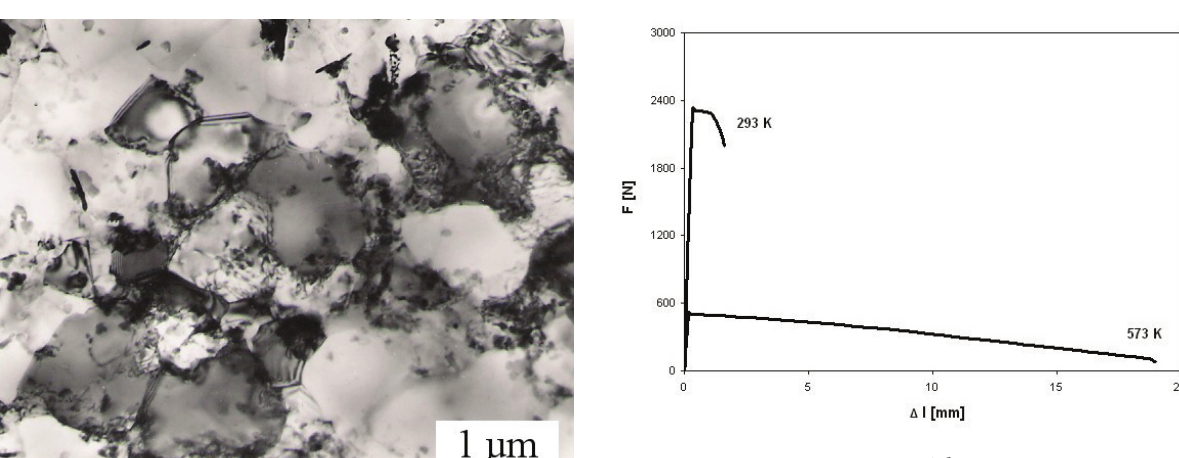
Figure 3. Load F on elongation (cid:2)l dependence at 293 K and 573 K temperatures.